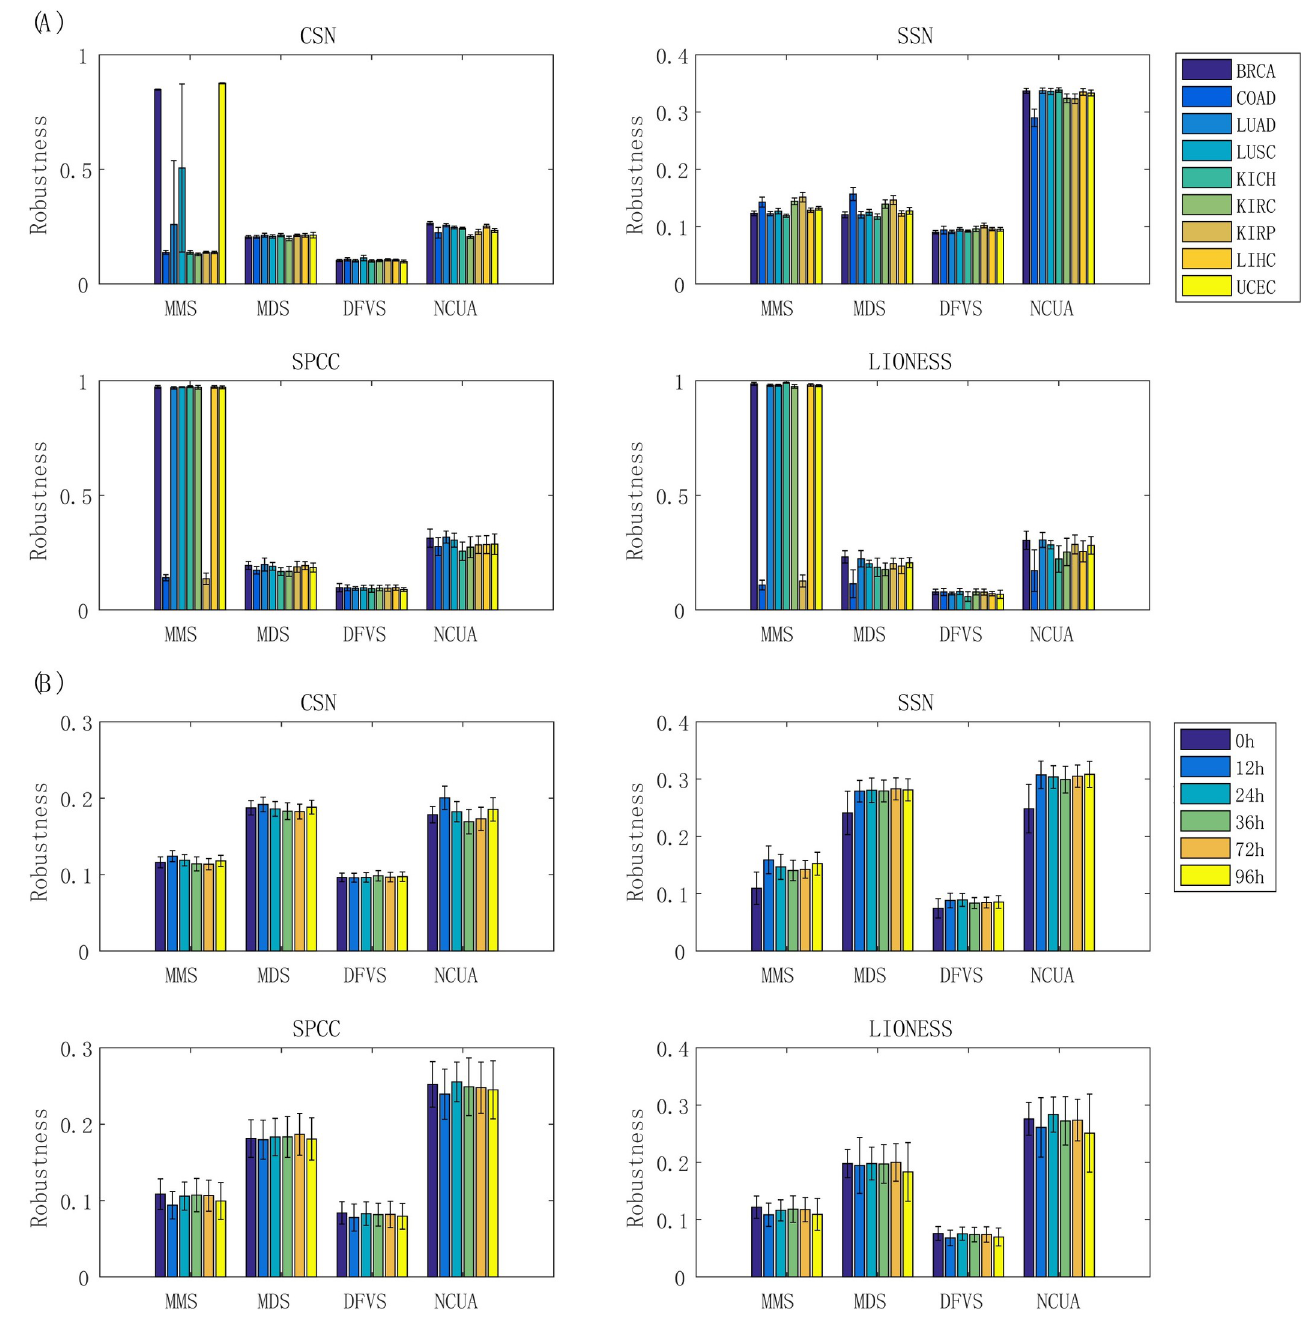
Fig 10. Evaluation of robustness of network structural control methods. The MMS, MDS, DFVS, and NCUA were compared, when two reference networks on CSN and SSN and SPCC and LIONESS used. The robustness of network structural control methods is shown in (A) for nine TCGA cancer datasets and in (B) for temporal single cell